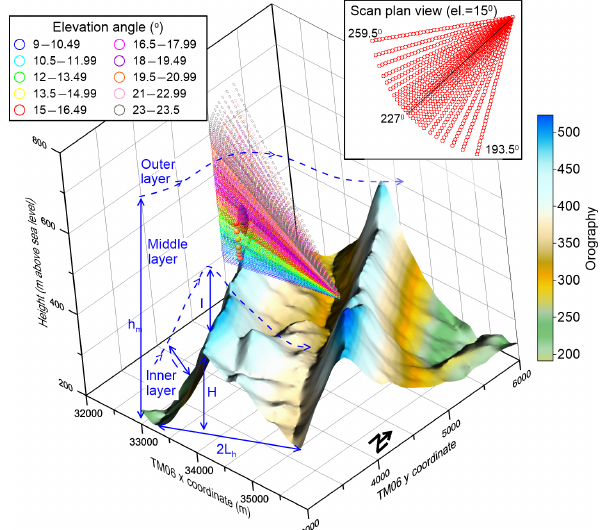
Figure 1. The orography of the Perdigão study area (shown in Por- tuguese TM06 coordinates with major spacing at 1km). As shown the topography is dominated by double ridges orientated northwest– southeast. The turbine location on the SW ridge is indicated by a black disc representing the rotor plane, and the measurement heights at meteorological mast Tower 20 are indicated by the red spheres. The scan points of the arc scans from the scanning Doppler lidar located in the valley are shown for each 30m range gate for 10 elevation angles from 9 to 23 ◦ and 23 azimuth angles from 193.5–253 ◦ . The inset scan plan view shows each measurement point (range gate) for the 15 ◦ elevation scan. The blue lines de- note the height ( H = 300m) and length scales ( L h = 800m) of the topography for southwesterly flow and the inner-layer height l and middle-layer height h m